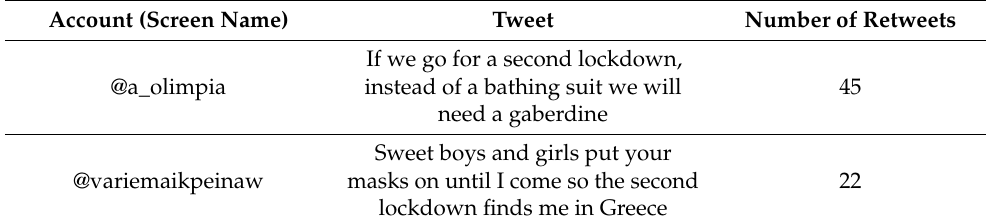
Table 7. Tweets regarding the fear of a second